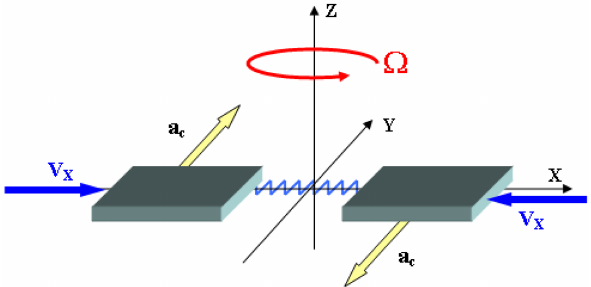
Figure 1. Sketch of the principle of operation of a MEMS gyro- scope.